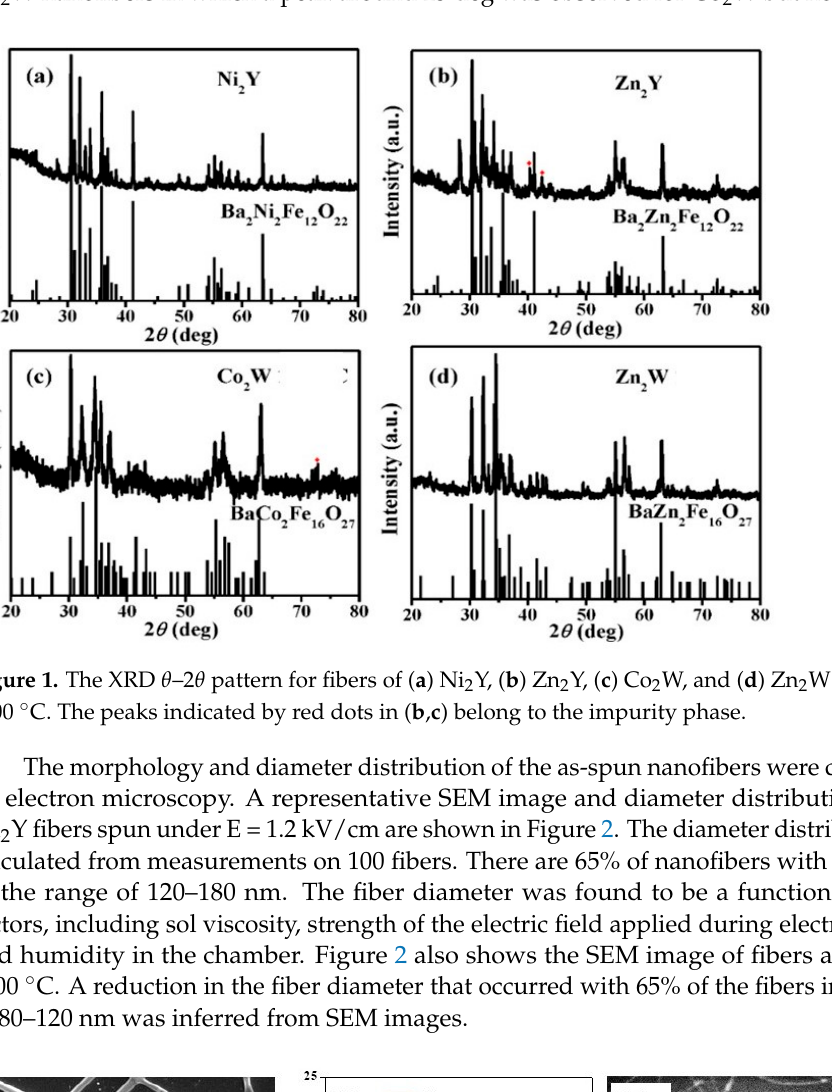
Figure 1. The XRD θ –2 θ pattern for fibers of ( a ) Ni 2 Y, ( b ) Zn 2 Y, ( c ) Co 2 W, and ( d ) Zn 2 W annealed at 1200 °C. The peaks indicated by red dots in ( b ) and ( c ) belong to the impurity phase. Figure 2. ( a ) SEM image of as-spun Zn 2 Y fibers, ( b ) fiber diameter distribution for as-spun fibers, and ( c ) SEM image of Zn 2 Y fibers annealed at 1000 °C.